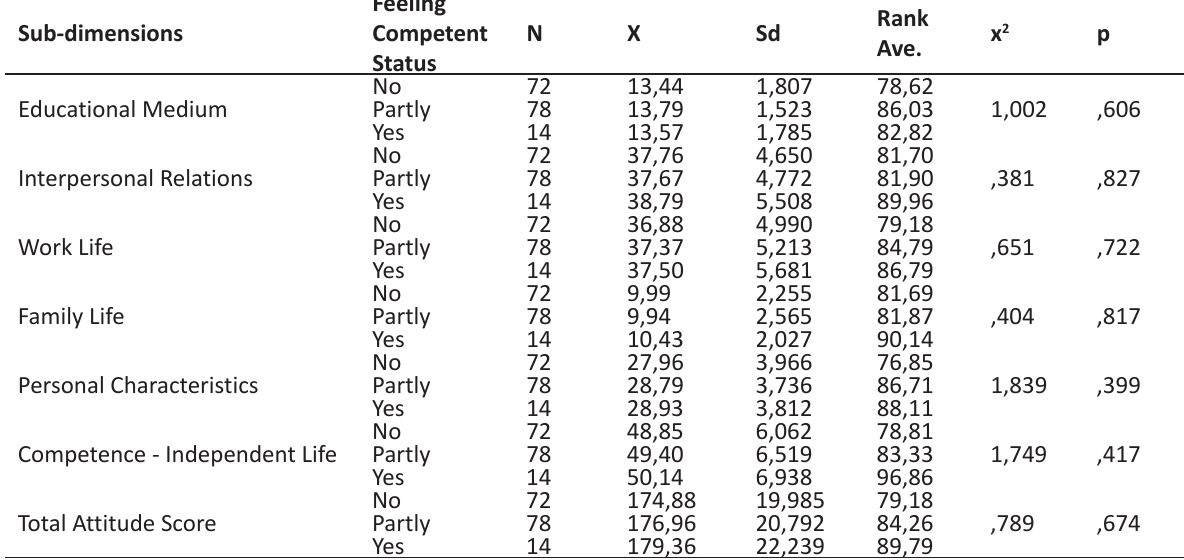
Table 9. Comparison of the Attitudes of the Participants towards the Handicapped according to the Feeling Competent in Special Education Field (the handicapped)